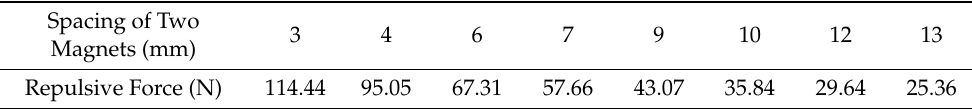
Table 3. Measurement results of the repulsive force [N] at the gap between two magnets [mm].